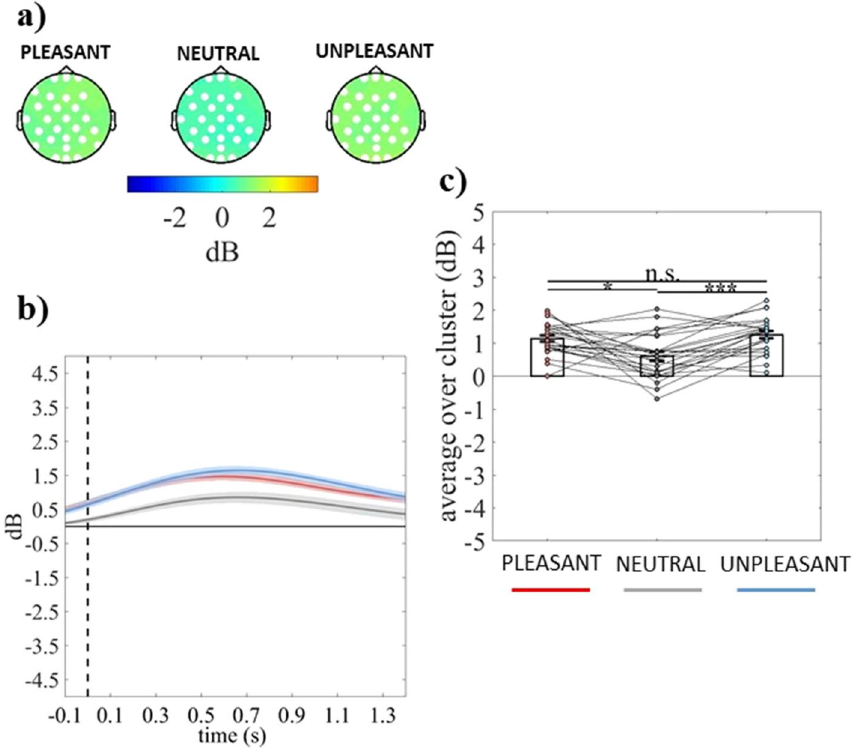
Figure 1. ( a ) Topography of the mean event-related delta power (dB) of individuals with dysphoria averaged over the significant time points (− 100 to 1400 ms time window) for pleasant, neutral, and unpleasant conditions. ( b ) Time course of grand-average event-related delta power of individuals with dysphoria averaged over the significant electrodes for pleasant (red line), neutral (grey line), and unpleasant (light blue line) conditions. Shaded areas represent ± standard error of the mean (SEM). ( c ) Mean event-related delta power of each participant (in the group with dysphoria) averaged over the significant electrodes and time points for pleasant, neutral, and unpleasant conditions. Each circle represents one participant; colored frames represent the mean event-related delta power across all participants and the solid black lines represent ± SEM. * p < .05; *** p <